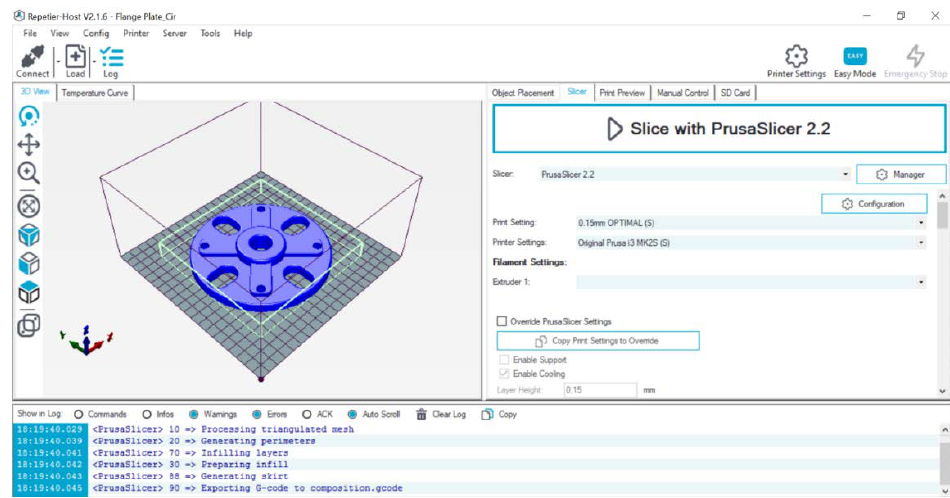
Figure 2. Repetier-Host Platform generating toolpath for a build.